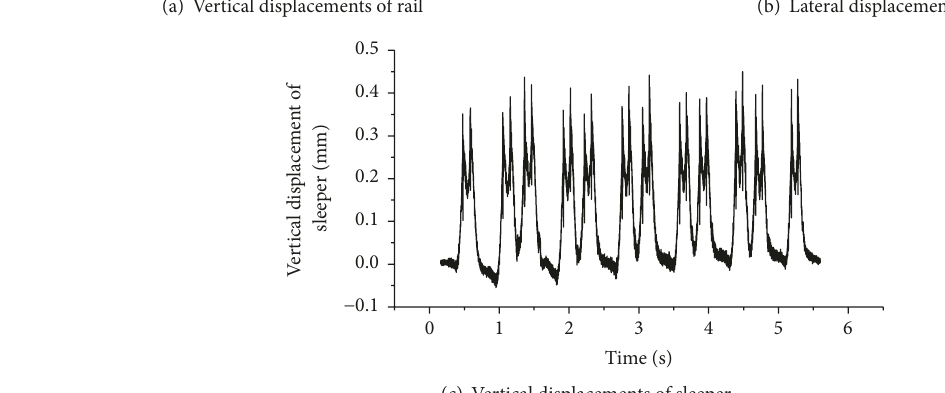
Figure 9: Time-history curves of the rail and sleeper for LEST in straight track.